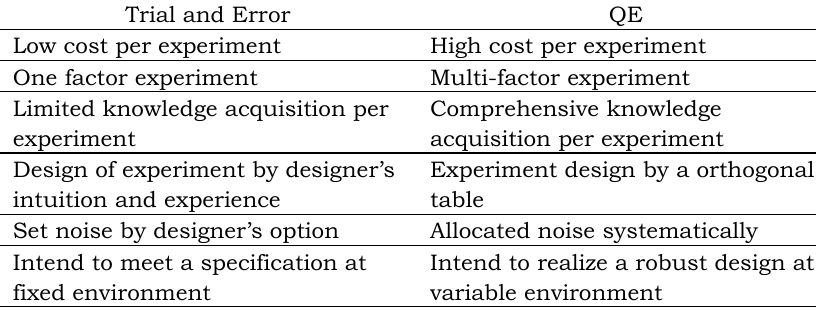
Set noise by designer’s option Allocated noise systematically Intend to meet a specification